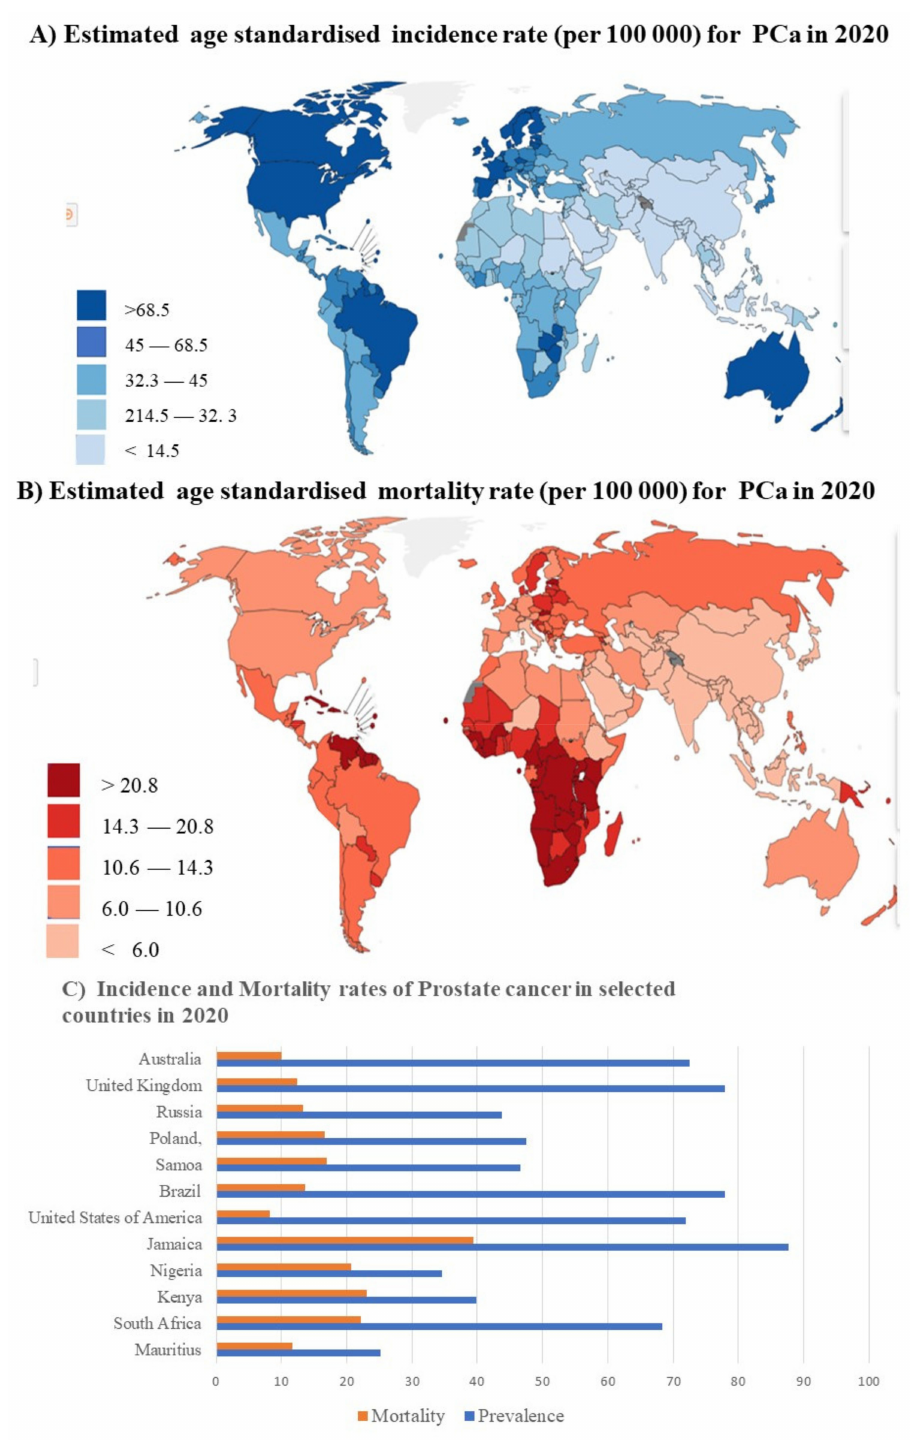
Figure 1. GLOBOCAN incidence and mortality statistics for Prostate cancer: ( A ) world map repre- senting the worldwide age standardized incidence rates of prostate cancer. The highest rates are observed to be in North America, the Caribbean, Western Europe, Brazil, Australia and New Zealand; ( B ) world map representing the worldwide age standardized mortality rates of prostate cancer. The highest mortality rates are in Sub-Saharan Africa; ( C ) a graph comparing the incidence and mortality rates of specific countries demonstrating various trends. All data fall within the 95% confidence interval